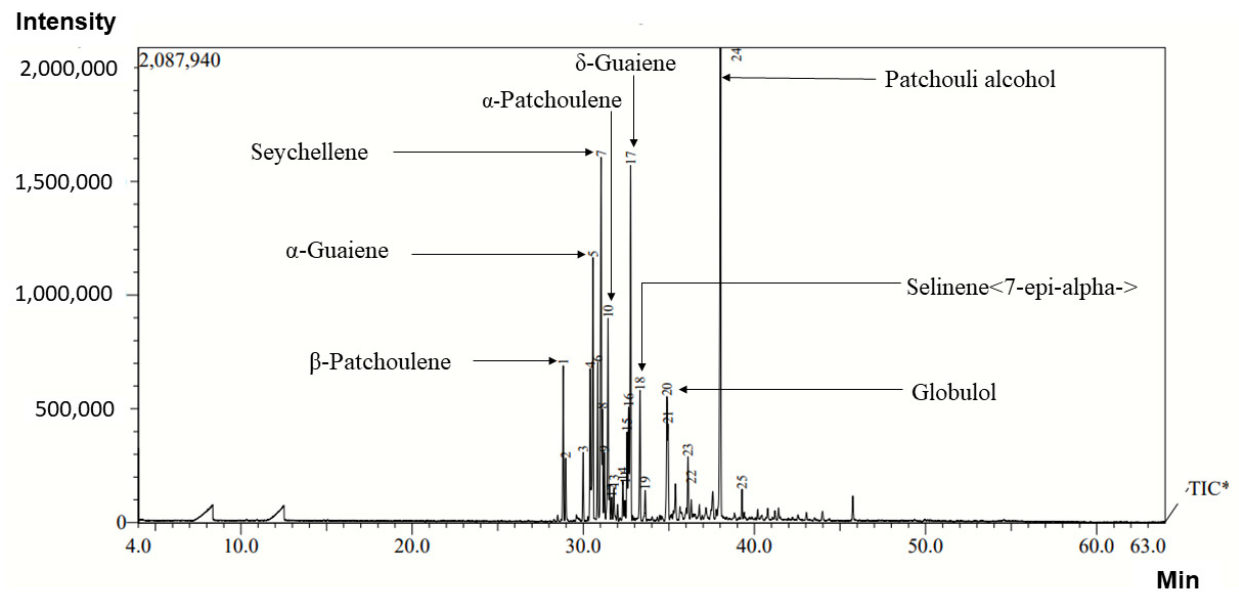
Figure 3. Representative GC–MS chromatograms of V. jatamansi oil sample.